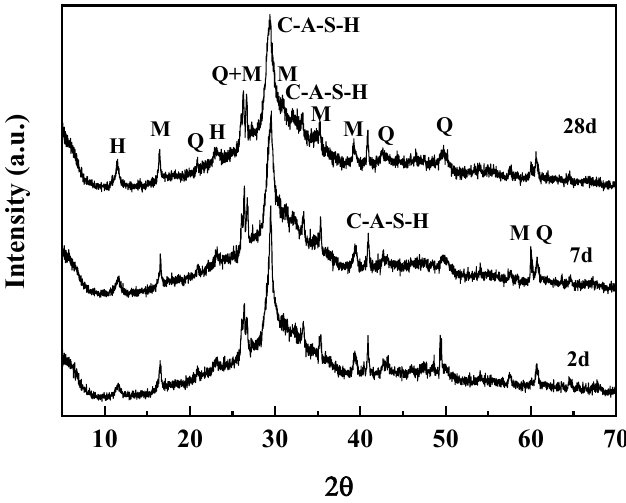
Figure 4. X-Ray diffractograms of pastes after 2, 7 and 28 days of curing; M = Mullite; Q = quartz, H = Hydrotalcite .